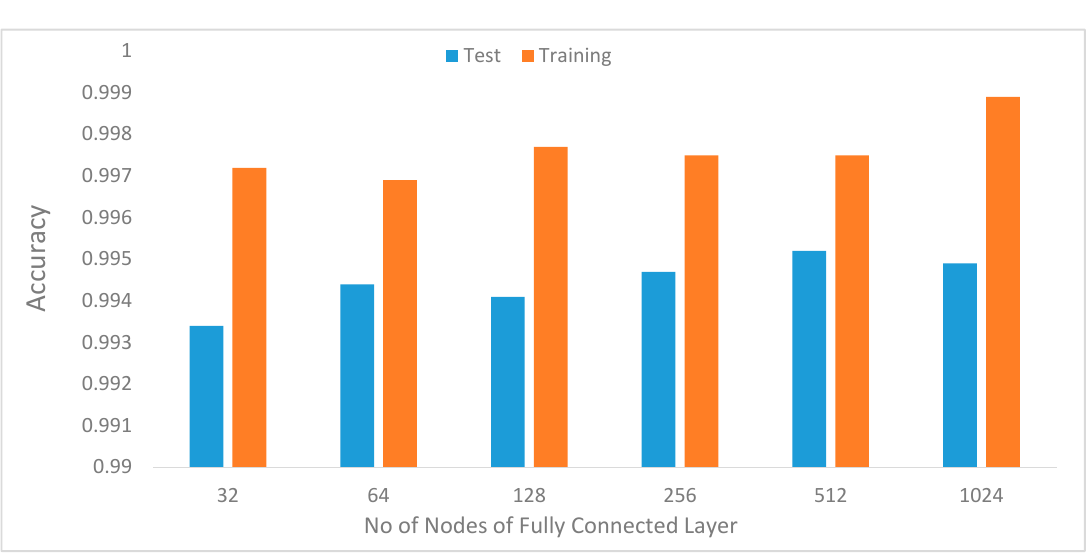
Figure 20. Model recognition accuracy with increasing number of CNN layers.